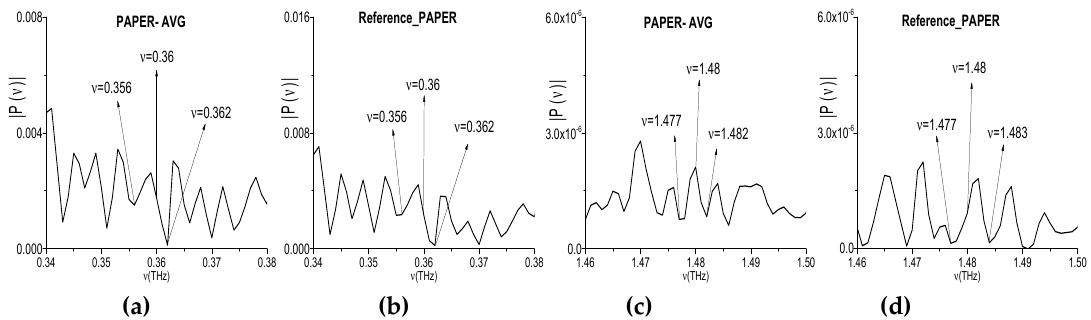
Figure 19. Paper_AVG signal spectrum ( a , c ) and reference spectrum ( b , d ) in the frequency ranges ν = [0.34, 0.38] THz ( a , b ) and ν = [1.46, 1.50] THz ( c , d ).